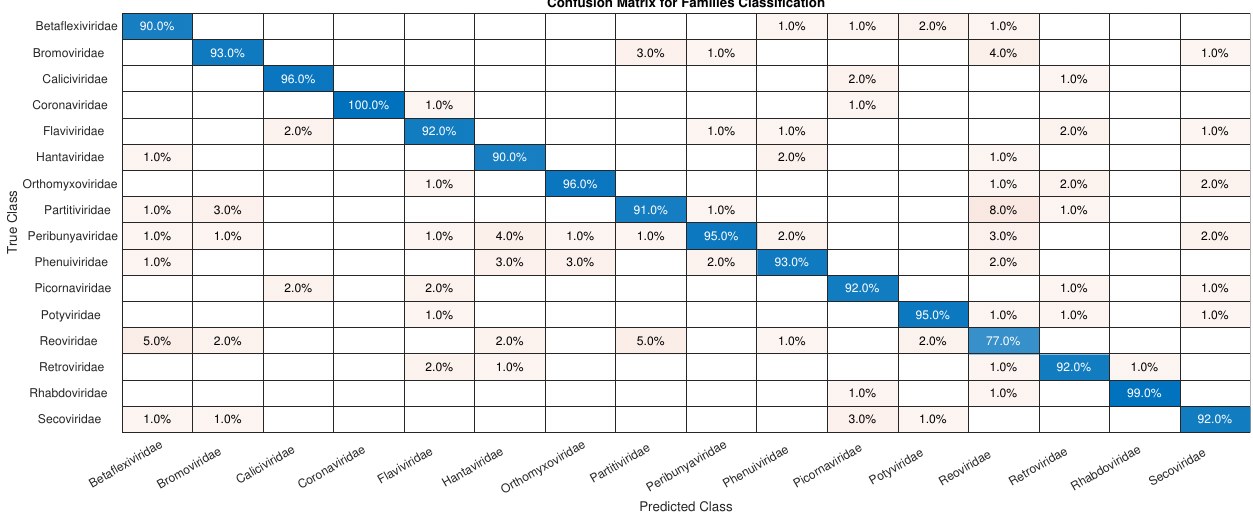
Figure 6. Confusion matrix for validation of the CNN using